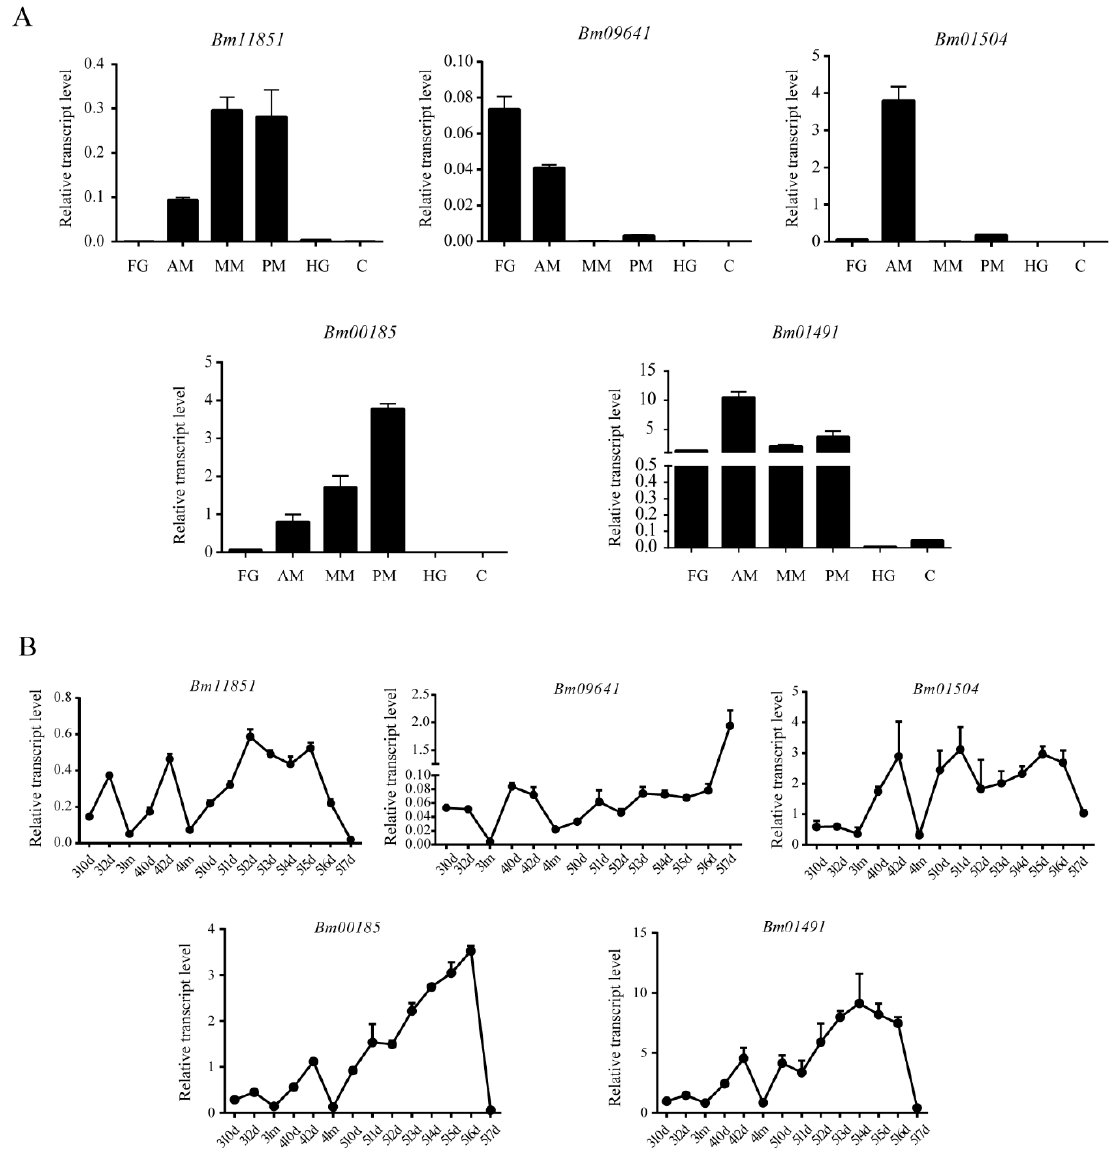
Figure 3. Temporal and spatial expression patterns of peritrophins in Bombyx mori . ( A ) Expression of peritrophins in different regions of the midgut. AM, Anterior midgut; FG, Foregut; HG, Hindgut; MM, Middle midgut; PM, Posterior midgut; ( B ) Expression of peritrophins in the midgut from the third instar to 7th day of the fifth instar. 3l, Third instar of larval stage; 4l, Fourth instar of larval stage; 5l, Fifth instar of larval stage; m, Molt; nd, Day n.